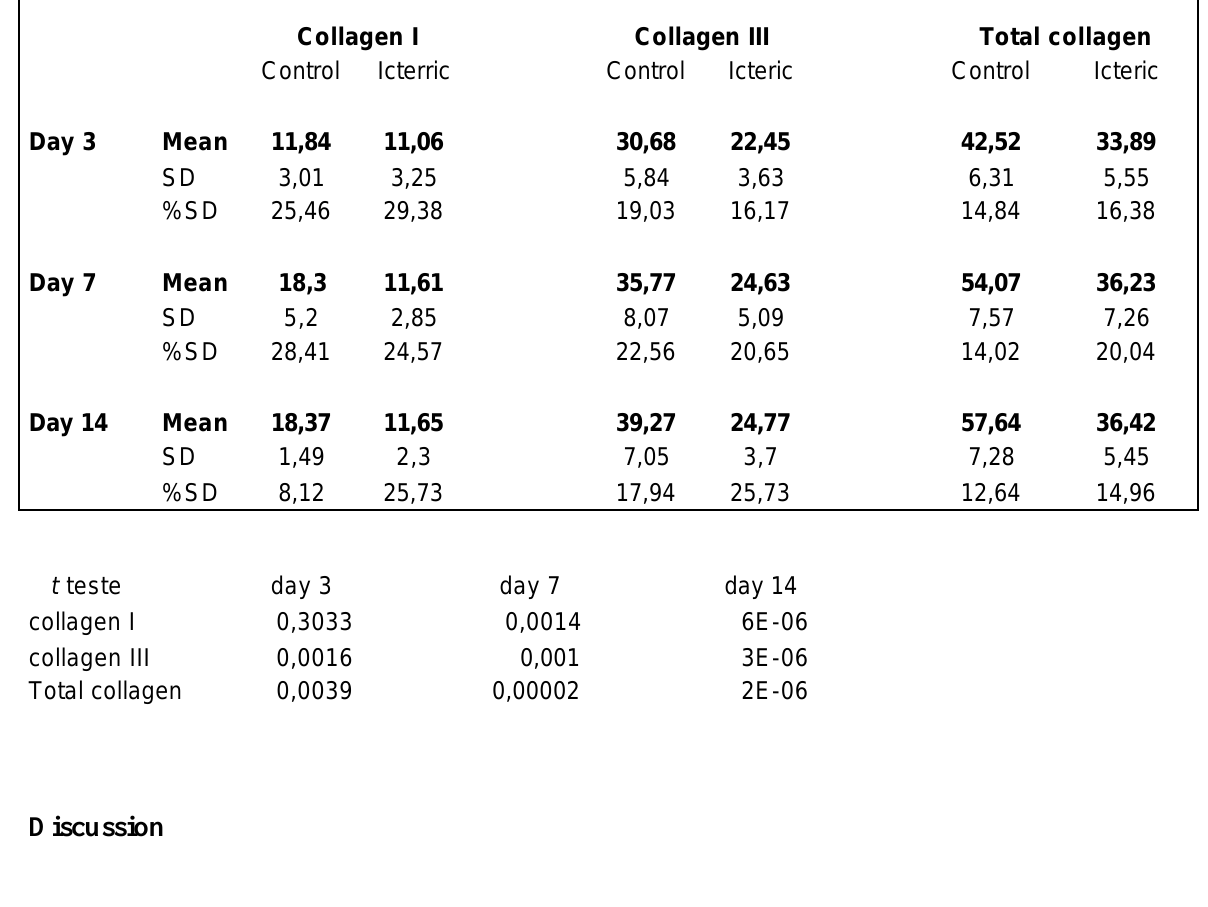
TABLE 3 – Mean percent area of the wound occupied by collagen at the three time points